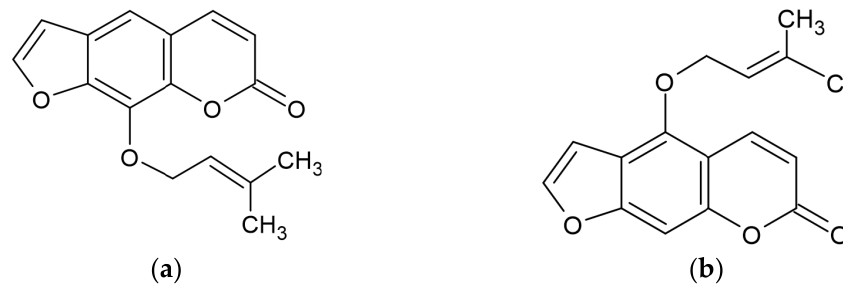
Figure 1. The structures of ( a ) imperatorin (CAS 482-44-0) and ( b ) isoimperatorin (482-45-1). Imperatorin, known as ammidin, marmelide, and marmelosin, is a naturally occurring active furocoumarin and phytochemical that is mainly found in citrus fruits (such as Citrus grandis and Citrus maxima ) and some species of the genus Angelica that are used as medicine (such as Angelica biserrate , Angelica dahurica , Angelica archangelica , Angelica pubescens and Angelica albicans ). It is known to exert many pharmacological properties, including anti- inflammatory effects on inflammation-associated lung, liver, osteoarthritis, ulcerative colitis, and neuro diseases [11–20] as well as anticancer [21–24] and antiviral activities [25–27]. A recent study has shown that imperatorin IMP can ameliorate PS-induced learning and memory deficits through the BDNF/TrkB and ERK/CaMKII α /CREB signaling pathways and the hypothalamic–pituitary–adrenal axis [28]. Imperatorin markedly inhibits activation of the PI3K/AKT/NF κ B pathway by suppressing the phosphorylation of PI3K, AKT, and and vascular alterations that are induced by high-fat/high-fructose diets (HFFDs) in rats through the restoration of adiponectin receptor 1 and eNOS expression and the suppression of p47phox expression [30]. However, it remains unknown as to whether imperatorin modulates melanogenesis by regulating the expression of MITF and TYR, including the MC1R/ α -MSH signaling pathway, the PI3K/AKT signaling pathway, the MAPK signaling